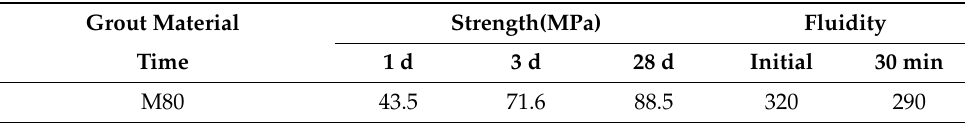
Table 2. Mechanical properties of grout material.